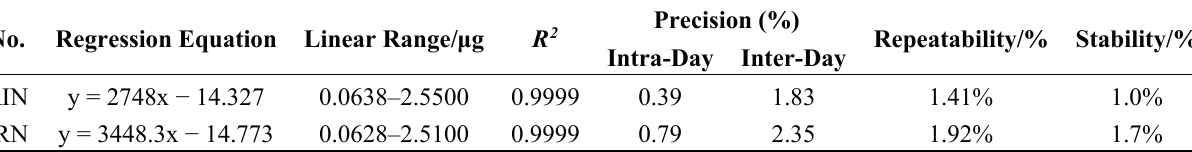
Table 3. Calibration parameters of the HPLC analysis for RIN and